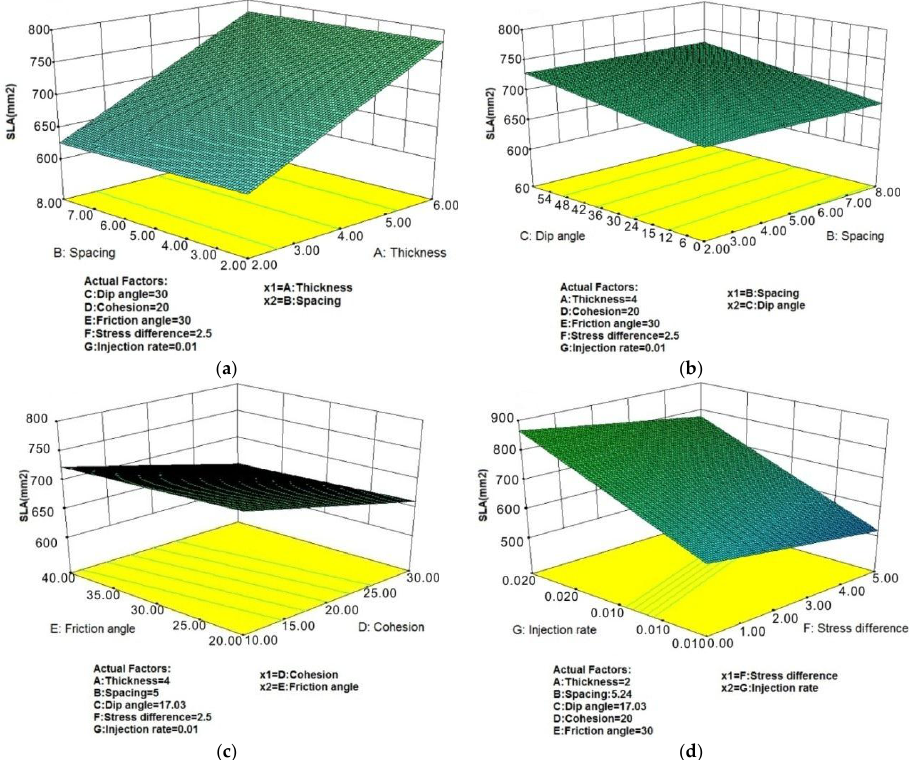
Figure 11. The influential factors studied on SLA response surface: ( a ) plots the influence of factor A and B on SLA; ( b ) plots the influence of factor B and C on SLA; ( c ) plots the influence of factor D and Eon SLA; and ( d ) plots the influence of factor F and G on SLA.